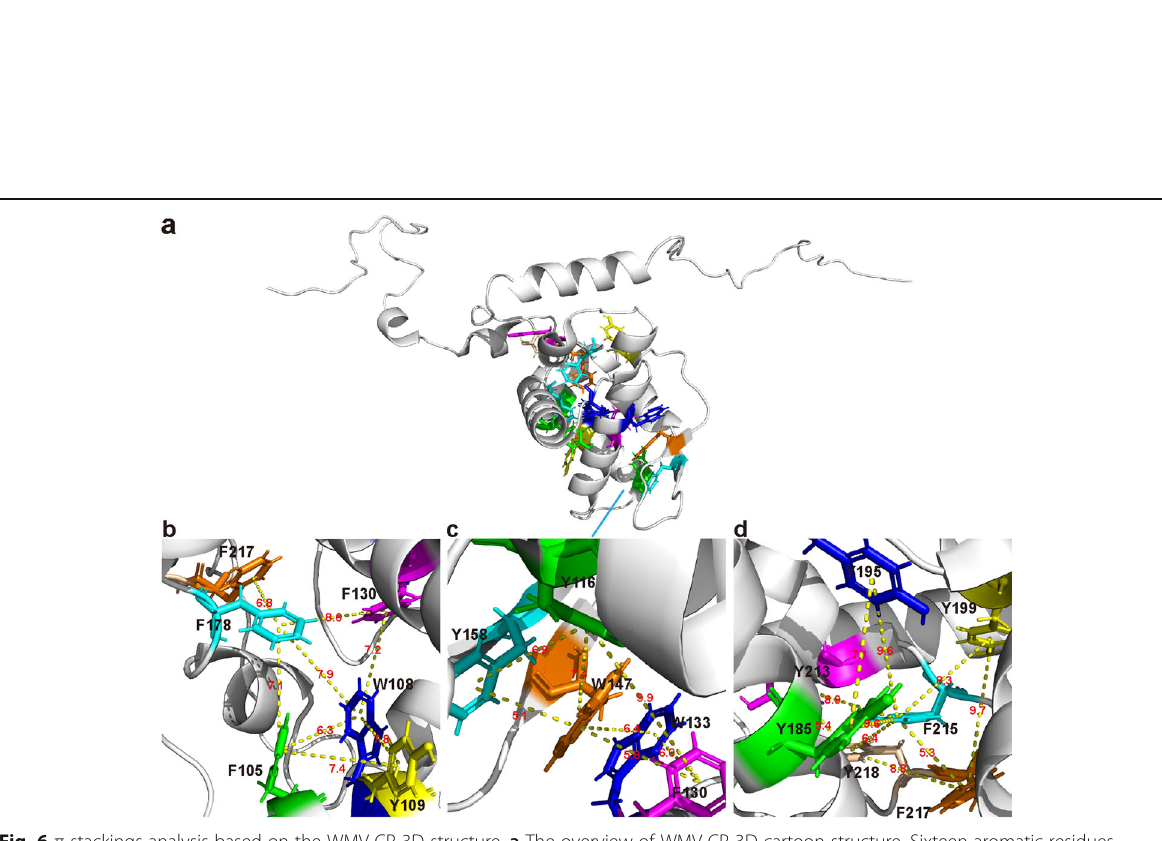
Fig. 5 Effect of π -stackings on virus particle assembly. a Virion of TVBMV-GFP or its mutants. Scale bar = 200 nm. The virus particles were purified from the infiltrated leaf tissues at 6 dpai. b The number of virus particles. Virus particles were counted in a field of 225 μ m 2 for each treatment. The values are the means ± SD from three fields per treatment